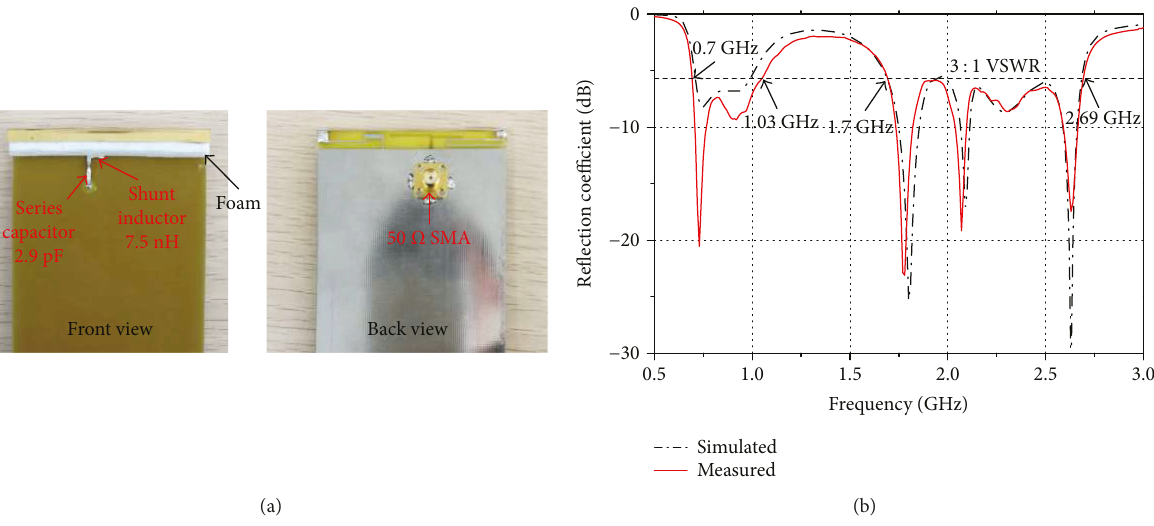
Figure 8: (a) Fabricated antenna and (b) comparison of simulated and measured re fl ection coe ffi cient of the proposed antenna.